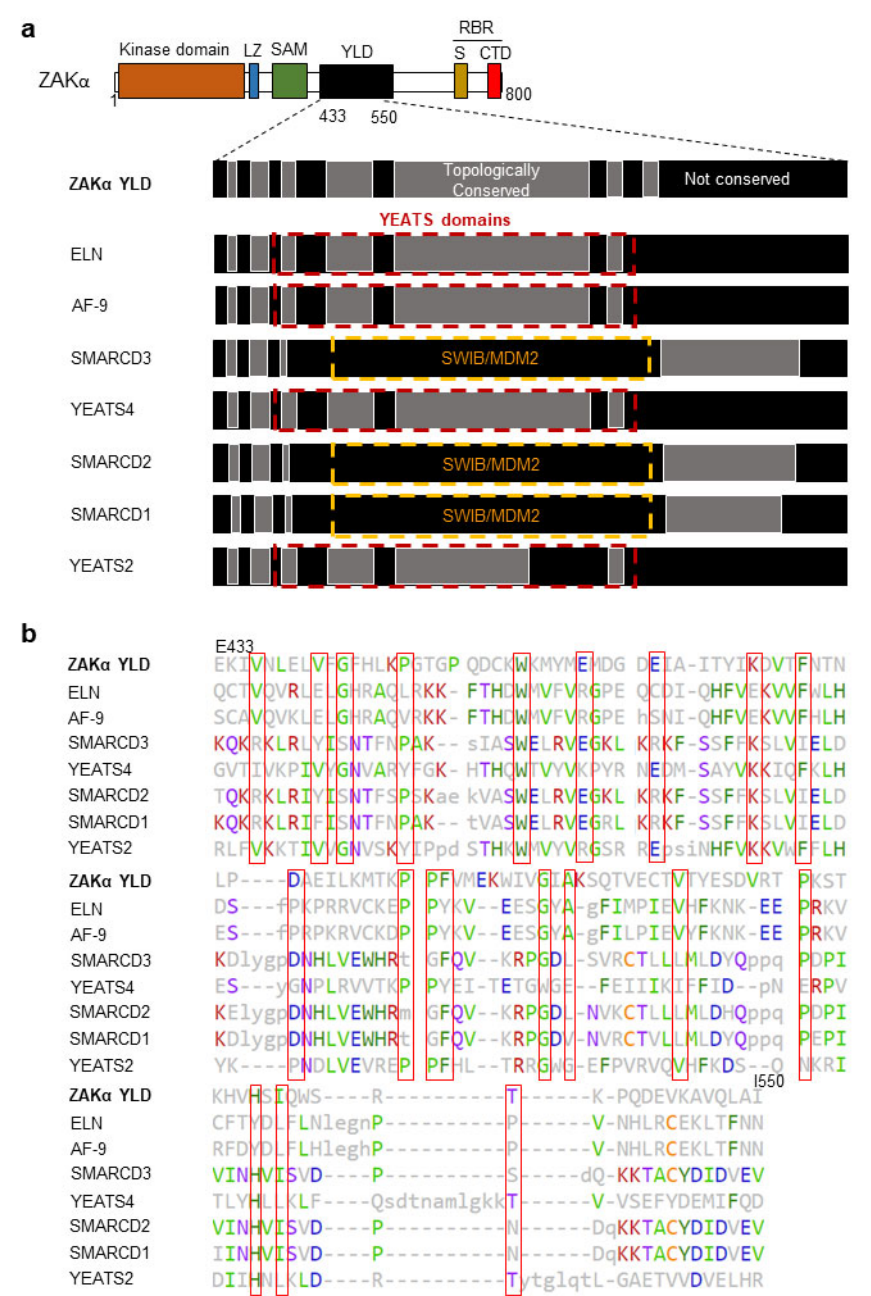
Figure 4. ZAK α contains a YEATS-Like Domain with high topological similarity to annotated YEATS domains. ( a ) The YEATS-Like Domain (YLD) of ZAK α shows high structural equivalence with YEATS-domains of hits from DALI analysis. Regions of high topological similarity (grey) are based on local Z-value scores when ZAK α YLD is superimposed on individual DALI hits. The methodology of Z-value score calculations is shown in Figure S1b. LZ, Leucine Zipper; SAM, Sterile Alpha Motif; YLD, YEATS-Like Domain; S, Sensor Domain; CTD, C-Terminal Domain; and RBR, Ribosome Binding Region. ( b ) Primary sequence alignment of ZAK α YLD and DALI hits from Figure 3. Gaps indicate unaligned regions. Uppercase letters denote structurally equivalent amino acids when compared to ZAK α YLD, whereas lowercase letters denote insertions relative to ZAK α YLD. The most frequent amino acid is colored in each column. Positions with a high conservation of specific amino acid residues are bracketed in red. Secondary sequence alignment is shown in Figure